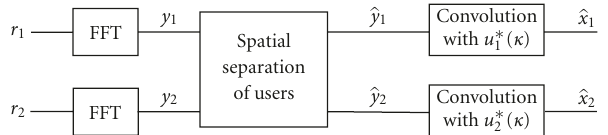
Figure 2: Receiver processing for simplified signal reconstruction with CFO compensation in the SDMA